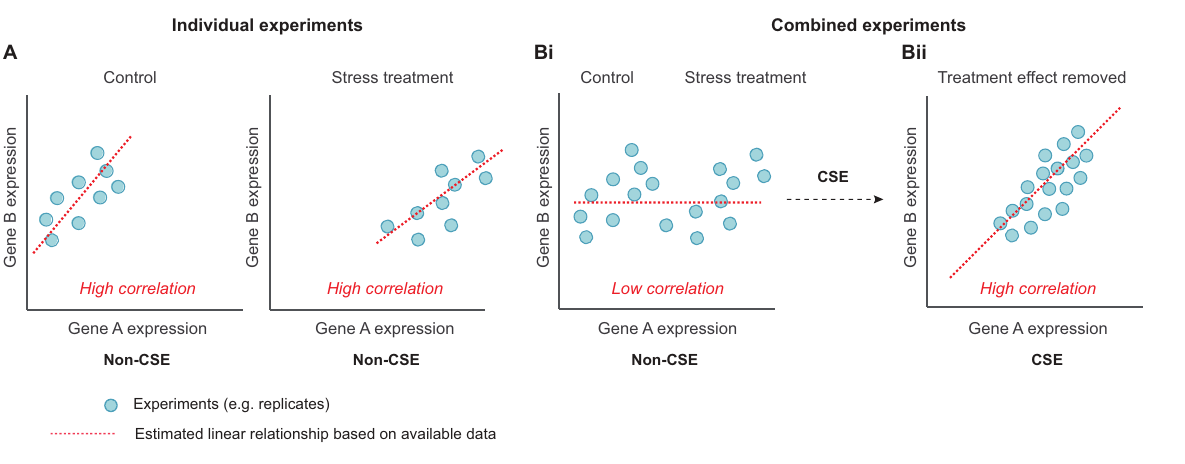
Frontiers in Plant Science |